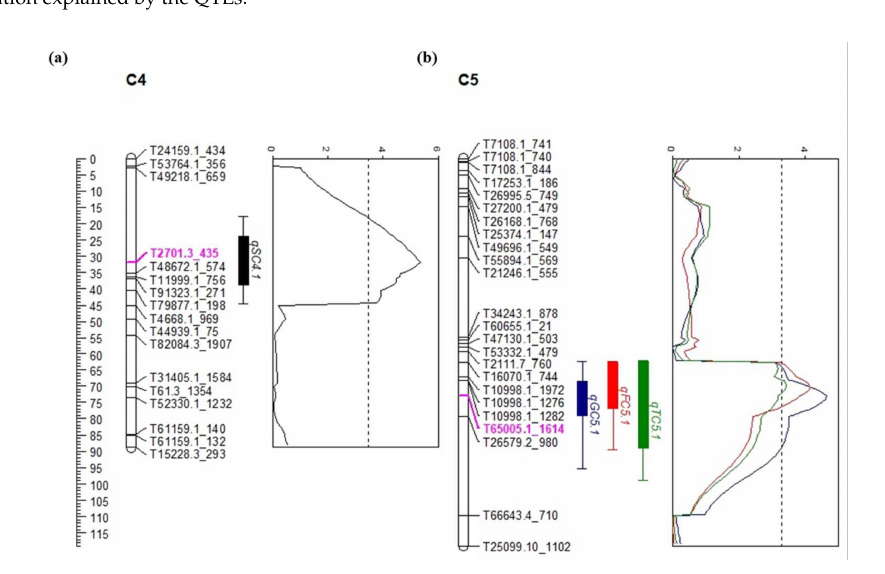
Figure 4. Quantitative trait loci (QTLs) associated with sugar content on chromosome 4 and 5. ( a ) QTLs position of sugar content ( qSC4.1 ) on chromosome 4 of the onion genetic map. ( b ) QTLs position of glucose ( qGC5.1 ), fructose ( qFC5.1 ) and total sugar ( qTSC5.1 ) content on chromosome 5 of the onion genetic maps. QTLs for qSC4.1 qGC5.1, qFC5.1, and qTSC5.1 are represented by black, blue, red and green, respectively. QTL plot obtained by composite interval mapping (CIM) analysis.